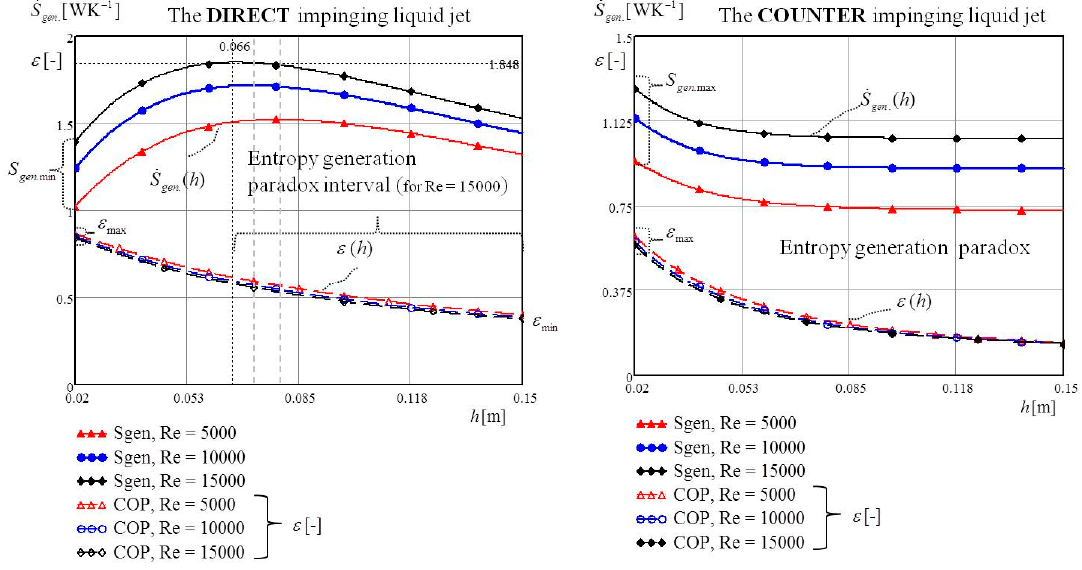
Figure 17. The entropy generation paradox for direct and counter impinging liquid